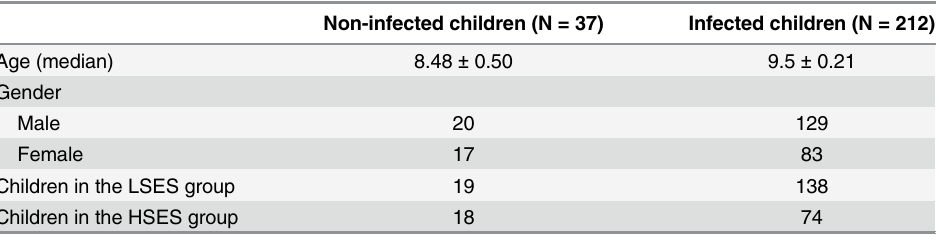
Table 1. Demographic characteristics of the study